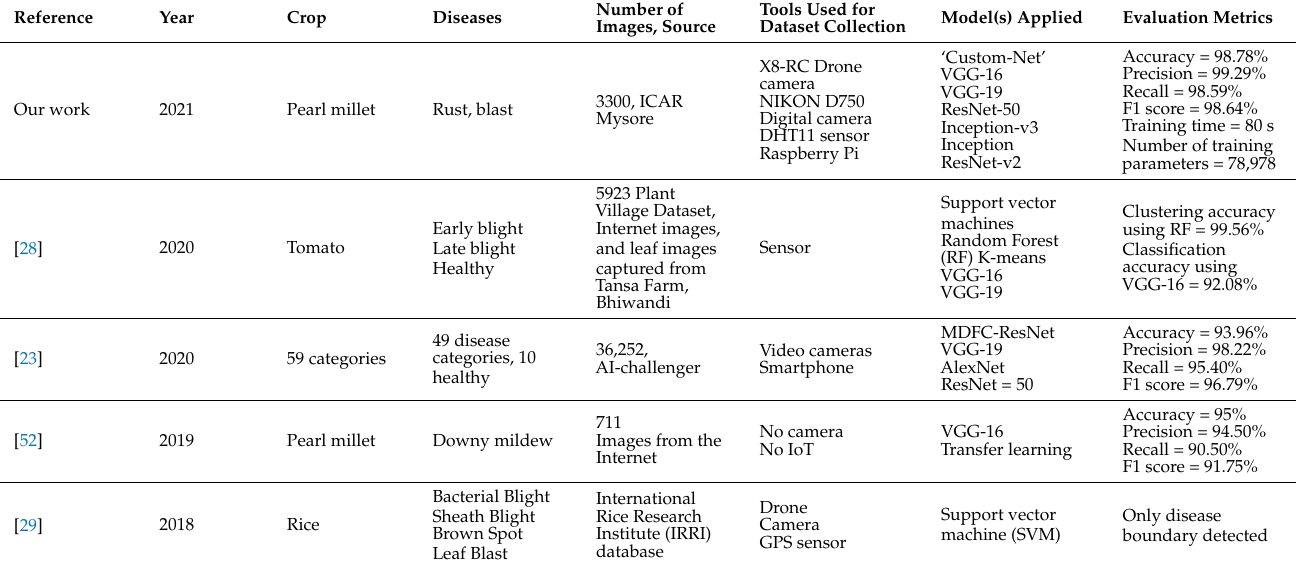
Table 7. Comparison of the proposed approach and the approaches available in